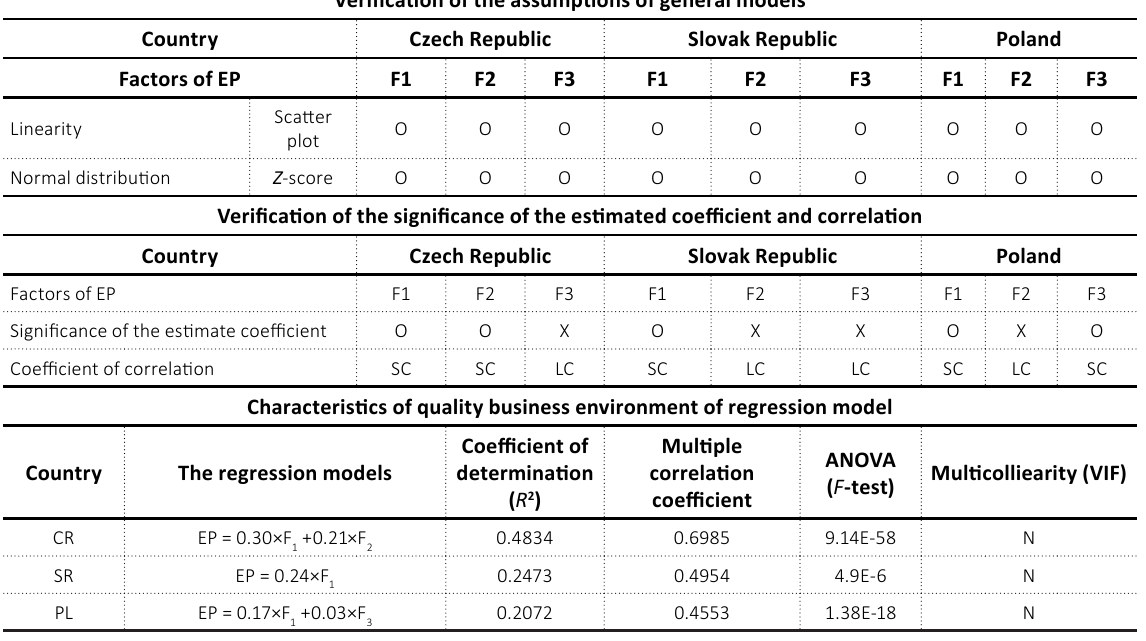
Table 5. Characteristics of the regression models